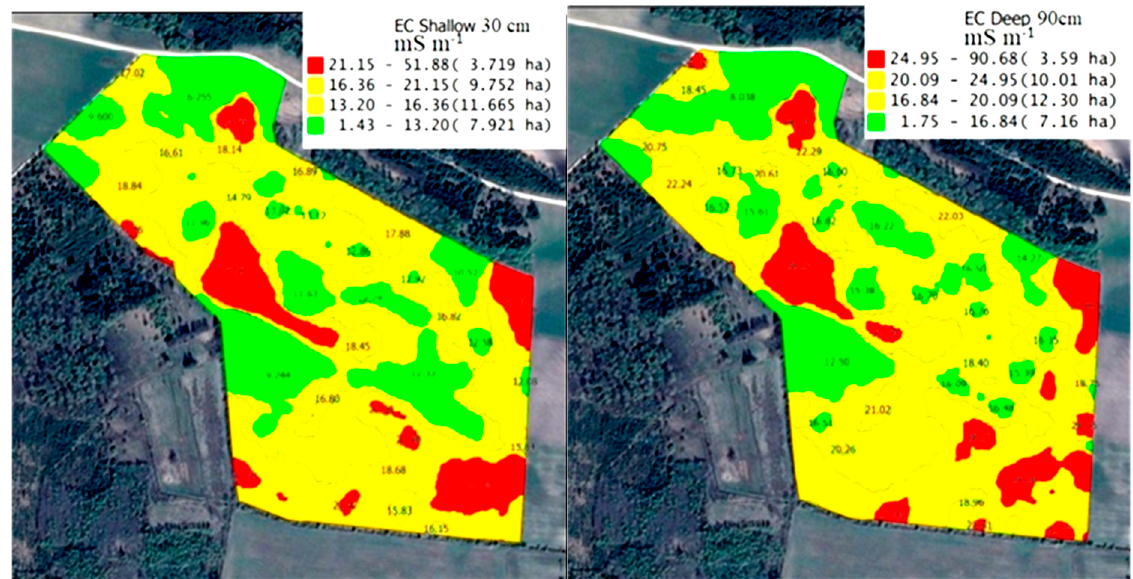
Figure 7. ECa maps of soil surface structure differences at the depth of 30 cm ( left ) and 90 cm ( right ). The colored parameter variation internal maps were created by the authors using a Veris MSP 3150; as a background layer, we used an ORT10LT digital raster orthophoto map of a territory in the Republic of Lithuania, M 1:10,000 (compiled 2012–2013) in the precision farming software AgLeader SMS